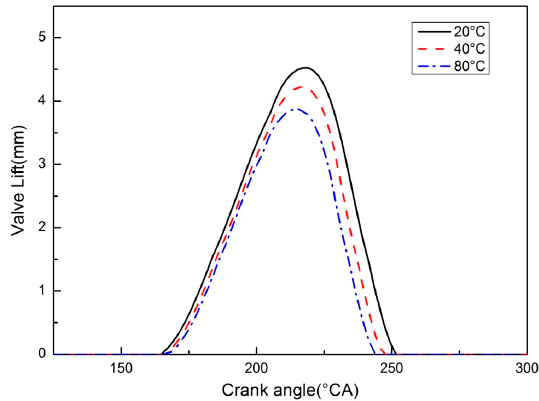
Figure 11. Valve lift curves at different oil temperatures.